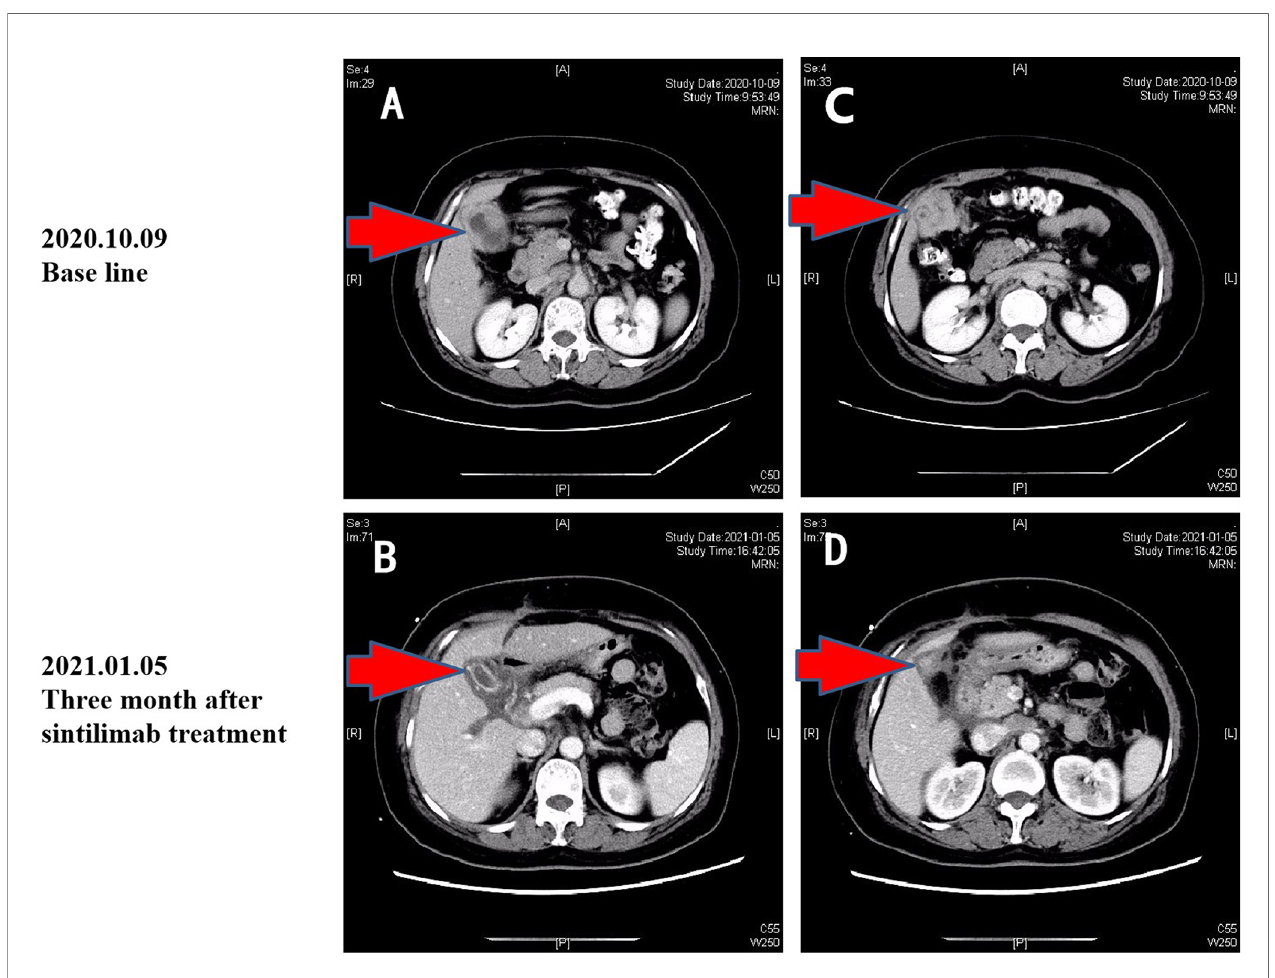
FIGURE 3 | CT images of baseline (A , C) and after sintilimab treatment (B , D)